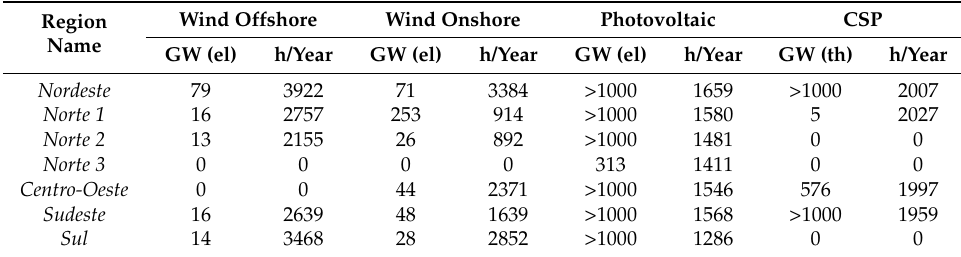
Table 2. Potentials for solar and wind power generation based on REMix-EnDAT [50] considered in the optimization. Note that installable capacities are displayed in GW and annual full load hours in h/year.